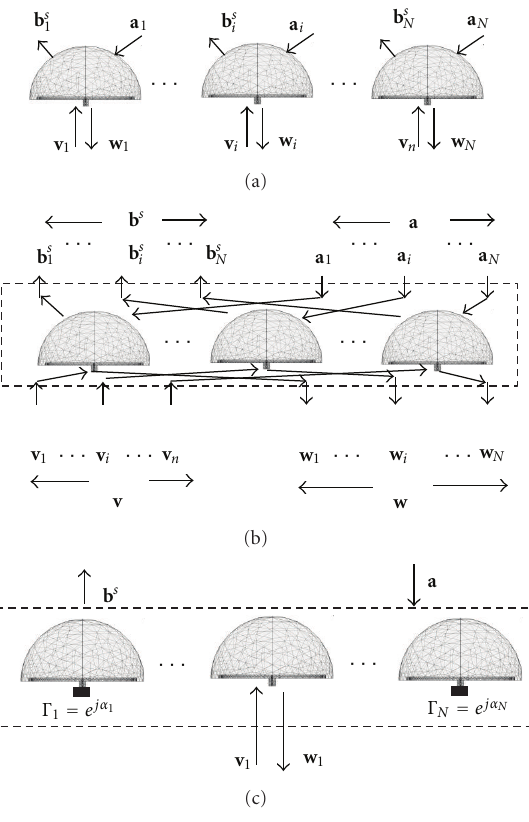
Figure 2: Computation of the GSM of the Planar ESPAR Array from the GSM i of the isolated